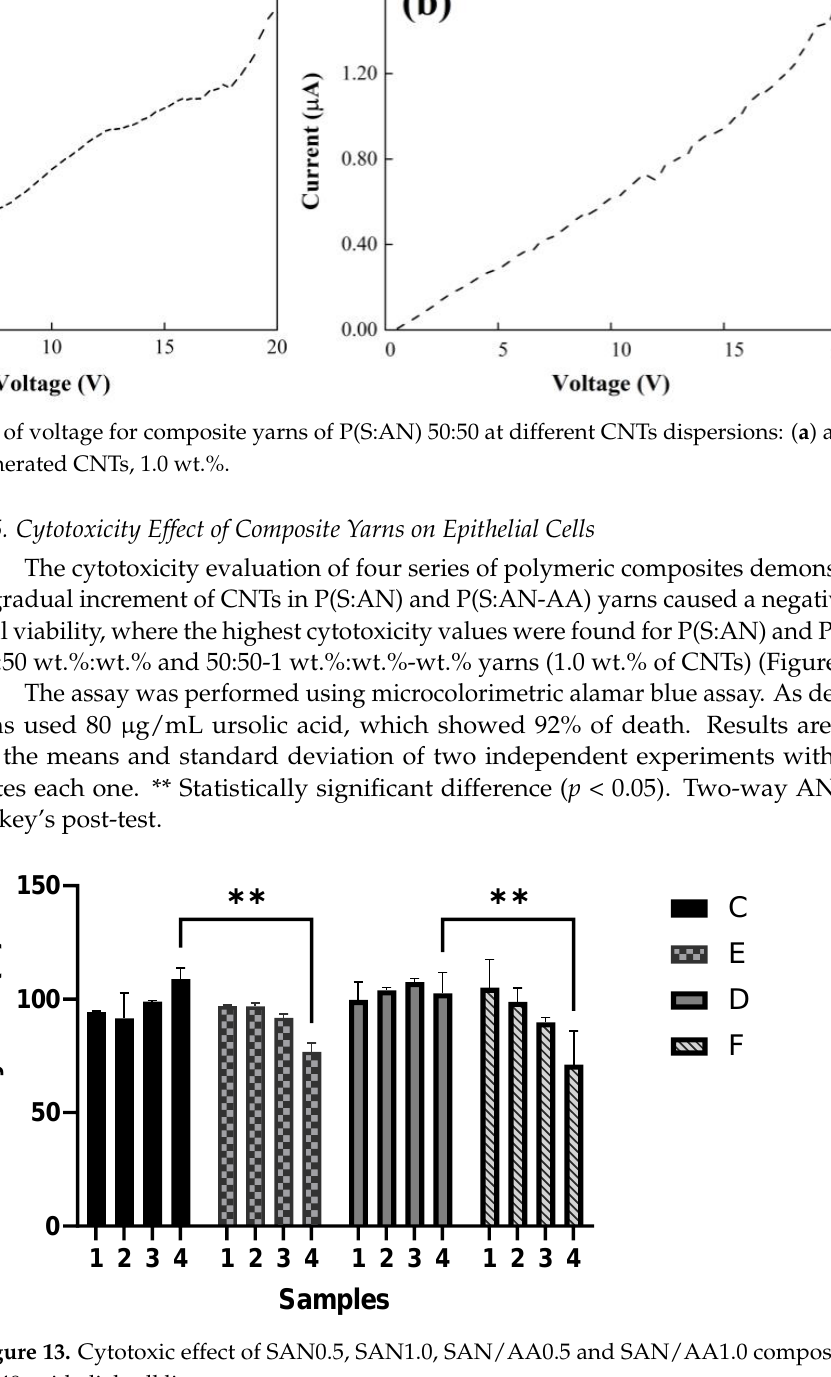
Figure 11. Curve elastic modulus ( a ) series SAN0.5, ( b ) SAN1.0, ( c ) SAN/AA0.5 and ( d ) SAN/AA1.0 composite yarns as a function of polymer percentage with kinetic degradation: 1st week ( ∎ ) ; 2nd week ( ● ) ; 3rd week ( ▲ ) and 4th week ( ★ ) . Error bars indicate standard deviation.